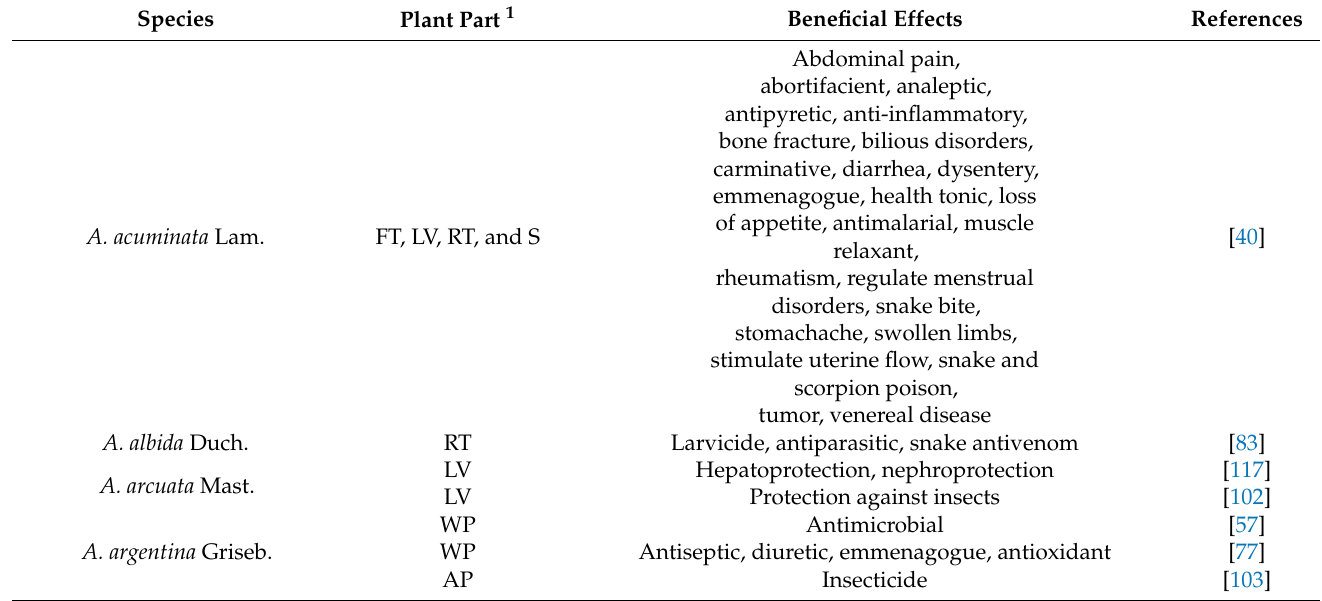
Table 2. Ethnomedicinal uses and biological activities of Aristolochia